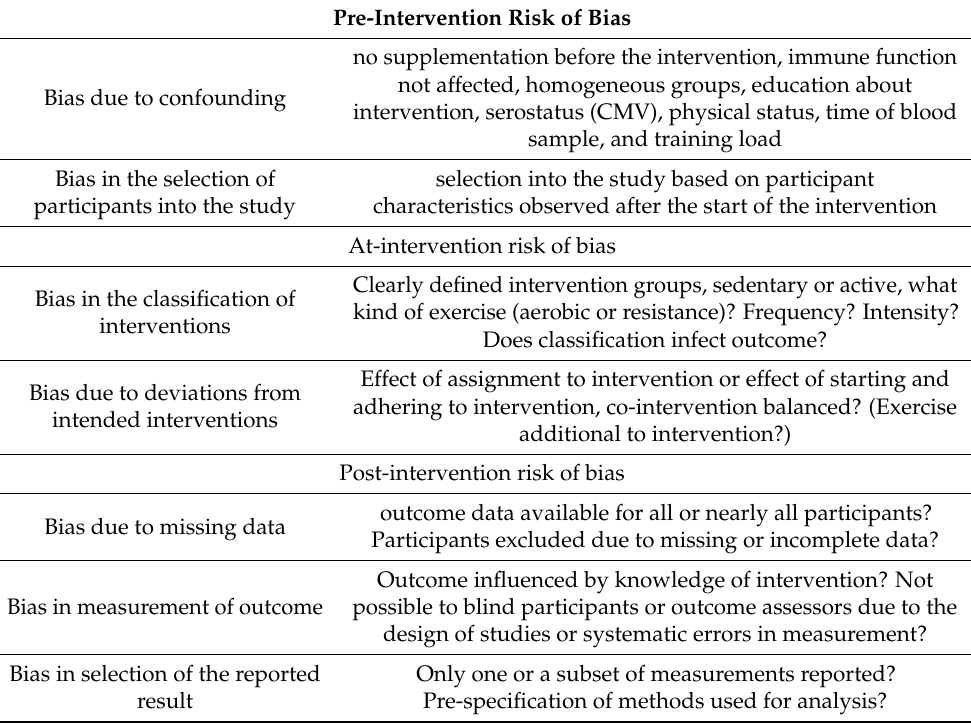
Table 5. Domains and content questions used to analyze the quality of non-RCT studies with the